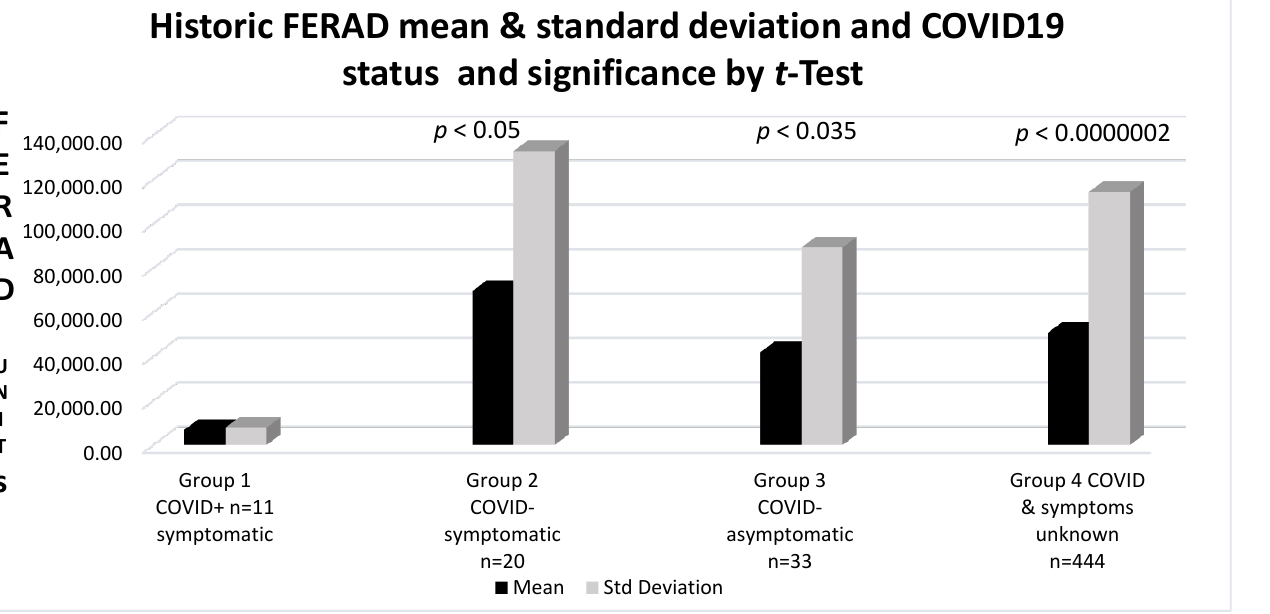
Figure 4. A bar diagram depicting pre-morbid FERAD values of COVID-19-positive patients, as compared to controls and COVID-19-negative test patients.